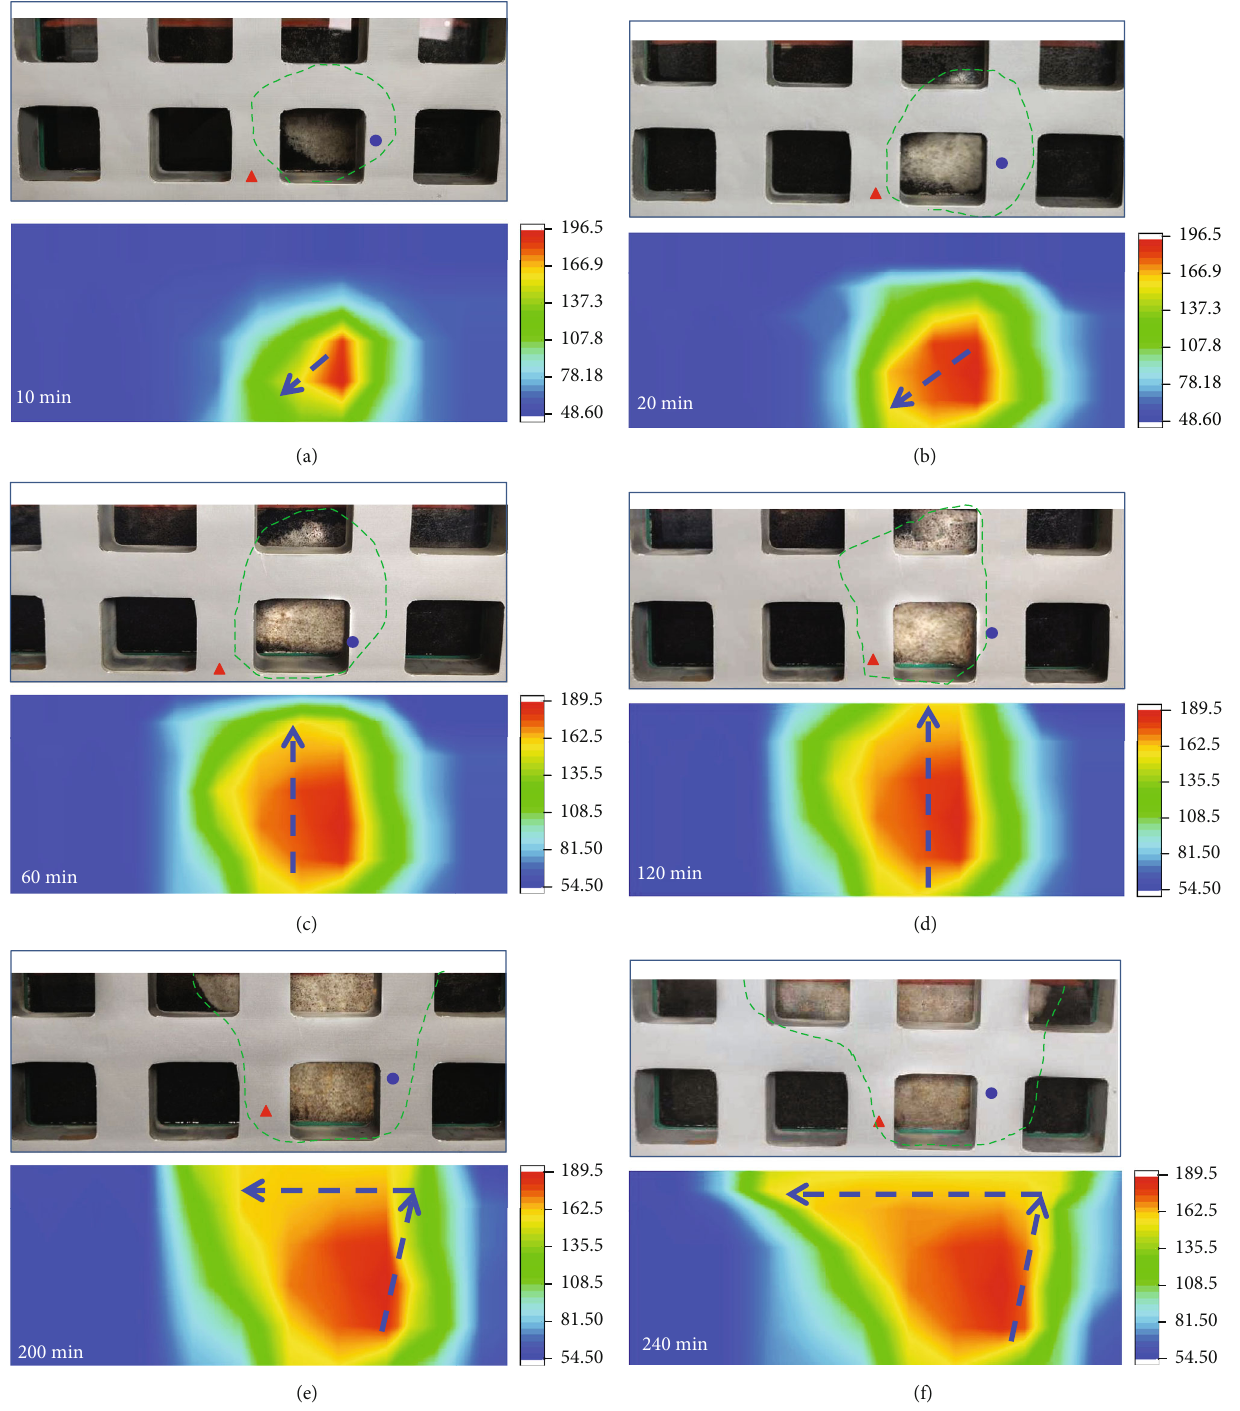
Figure 12: Pictures of steam chamber development and corresponding temperature pro fi